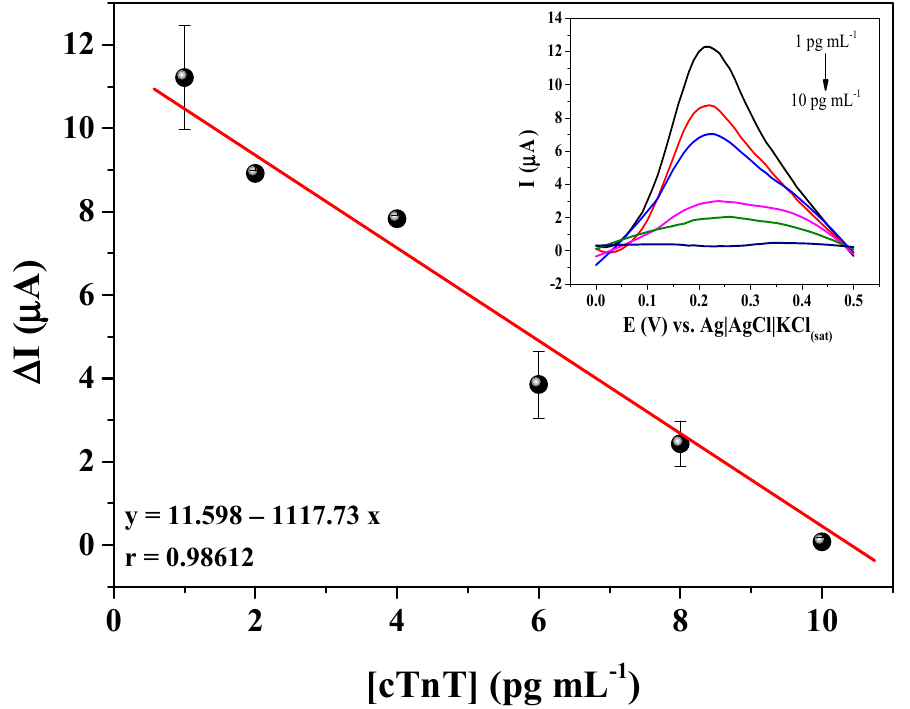
Figure 7. Calibration curve of the immunosensor in a spiked serum sample for different cTnT concentrations (1, 2, 4, 6, 8, and 10 pg mL − 1 ) measurements performed in 5 mmol L − 1 [Fe(CN) 6 ] 3 − /4 − solution prepared in 0.1 mol L − 1 KCl.